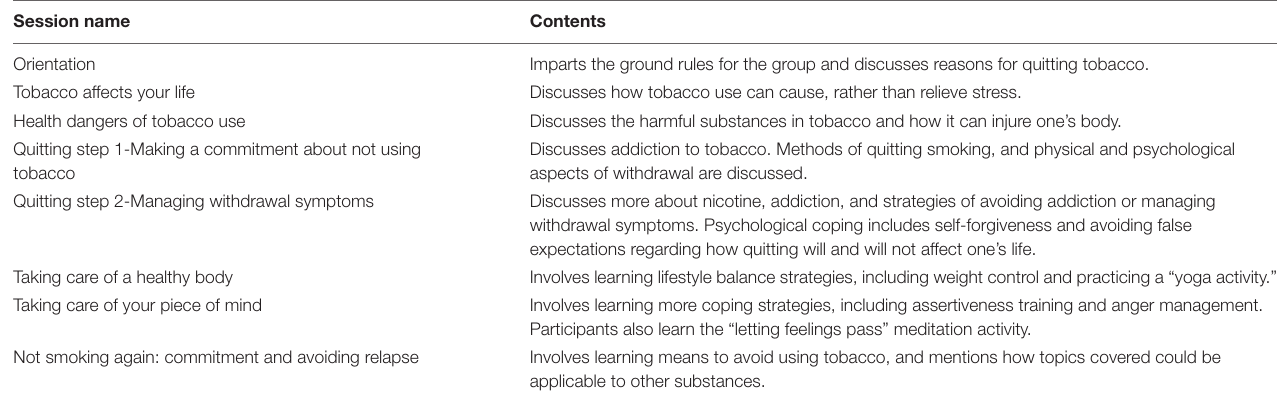
TABLE 1 | Project EX sessions and